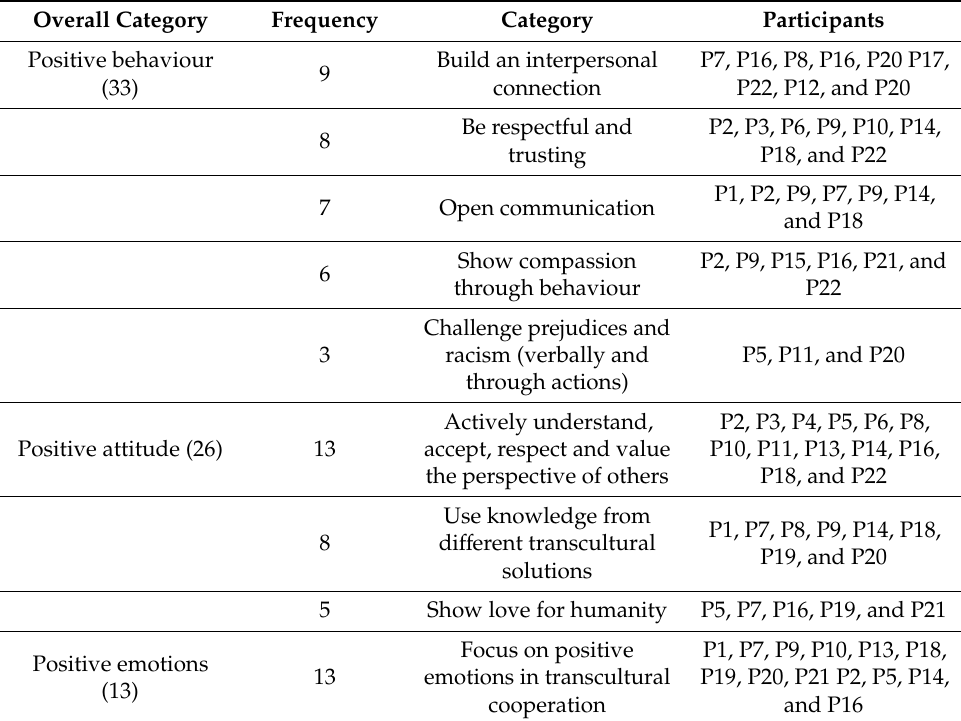
Table 3. Manageability and